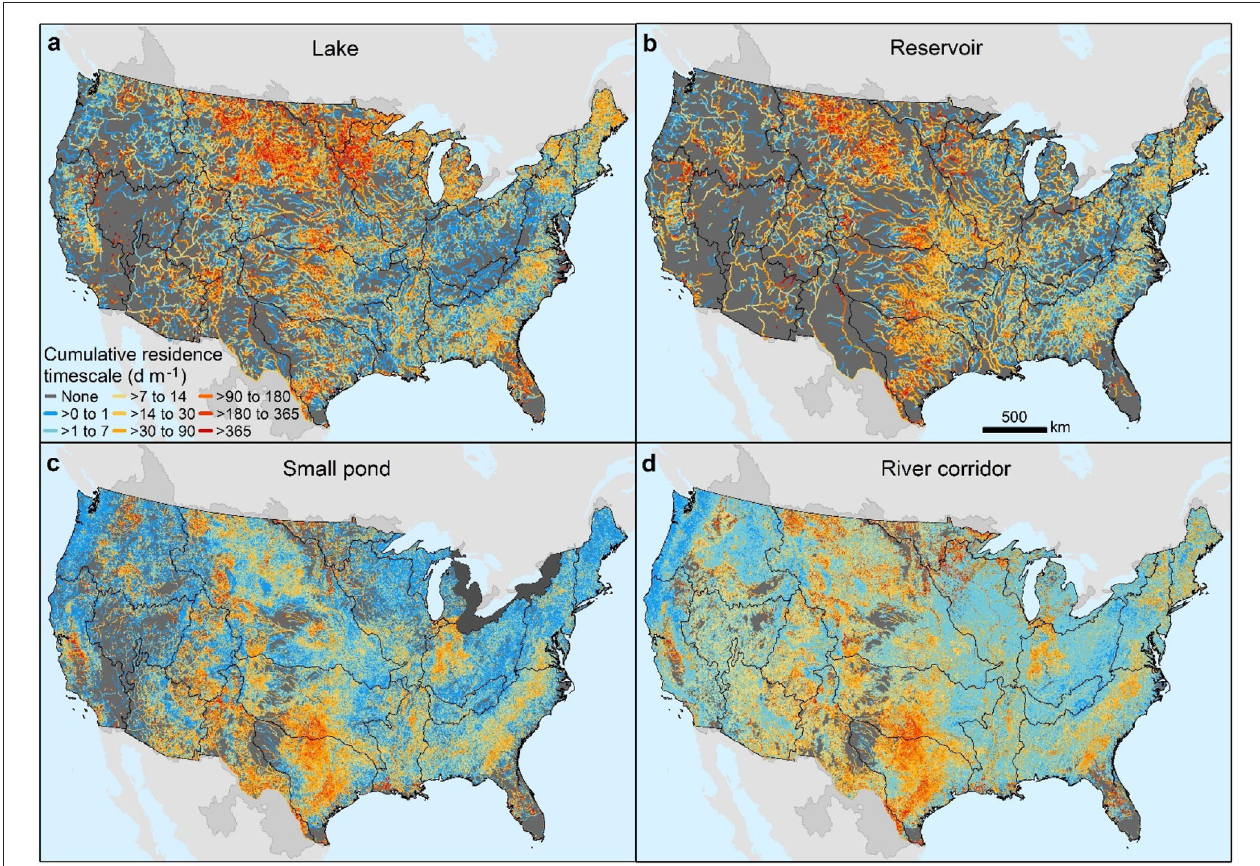
FIGURE 5 | Cumulative area-weighted water residence timescale for lakes (a) , reservoirs (b) , small ponds (c) , and the river corridor (d) . Black boundaries designate HUC-2 river